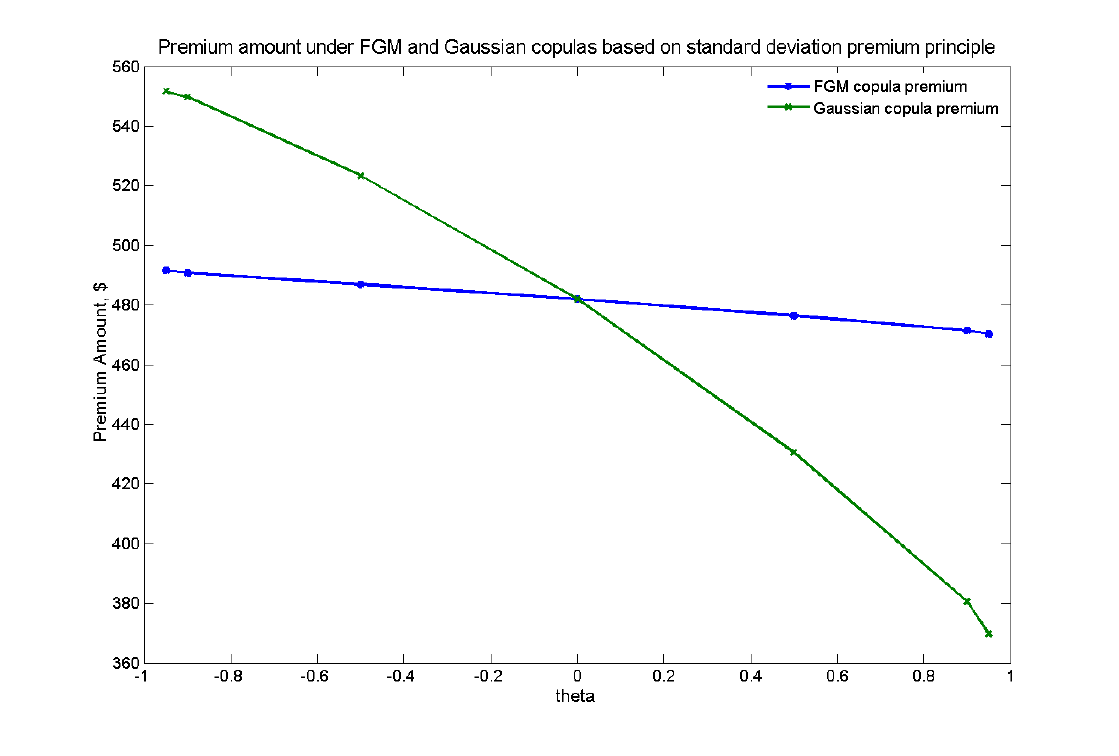
Figure 6. The loaded premium under the Gumbel copula based on the SD premium